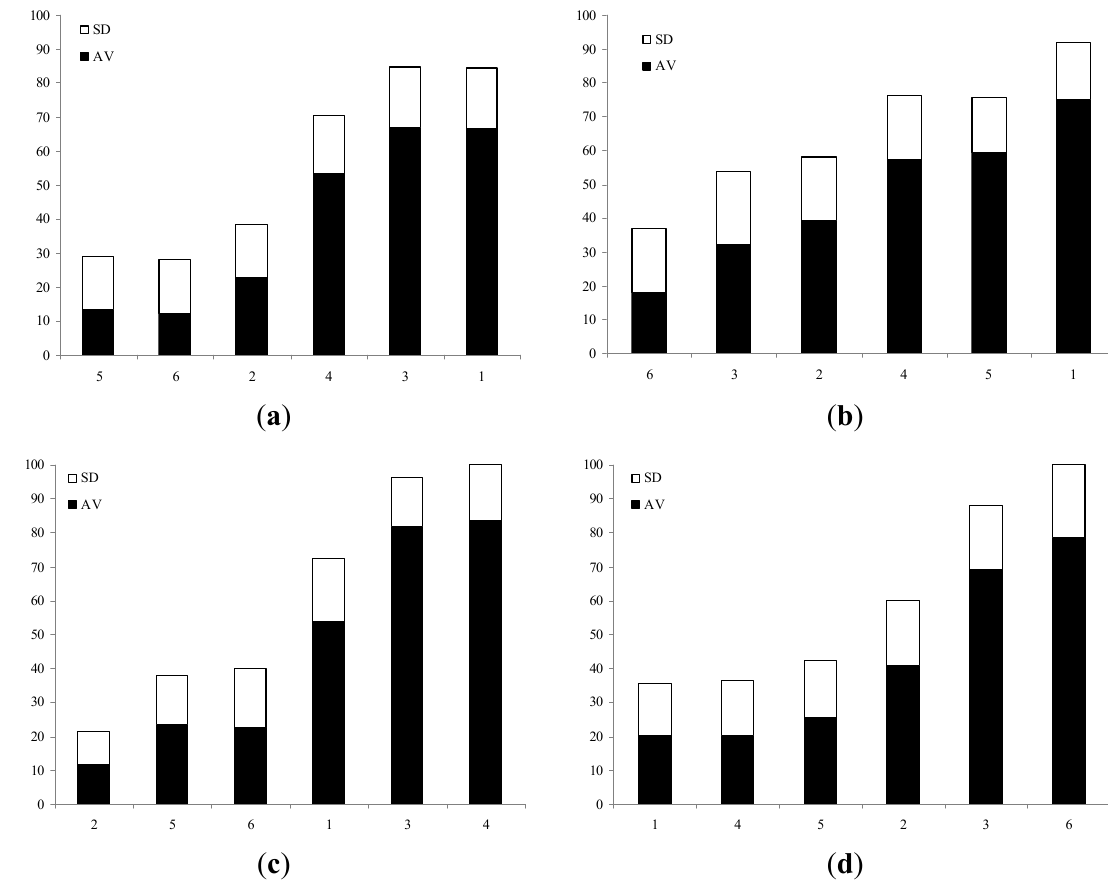
Figure 2. Stage 3 estimations (%) by ecology students for the variables ( a ) aesthetics ; ( b ) land cost ; ( c ) habitat for species ; and ( d ) safety based on different pictures represented by numbers on the x-axis. SD, standard deviation; AV,